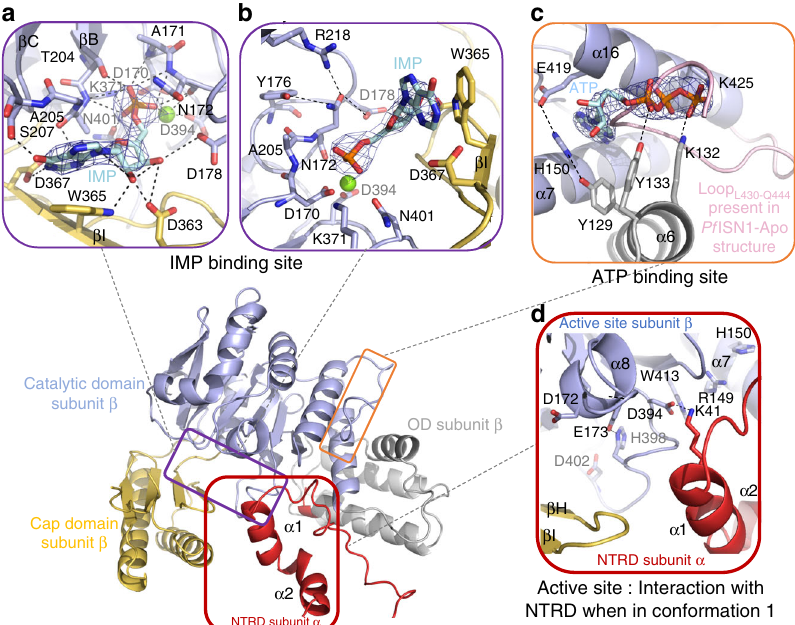
Fig. 4 Structural features of Pf ISN1. a , b Structural organization of the IMP binding site in the substrate binding state . c ATP-binding site in a pre-activated state with the C-terminal loop from the apo structure superposed. d Inter-domain communication of NTRD when this latter is in conformation 1.The 2 Fo – Fc electron-density maps (blue mesh) are contoured at 1 σ and Mg 2 + is depicted as a green Pf ISN1 H150V - Δ C10 is no longer inhibited by ATP and Pf ISN1 H150V -Apo is not activated by ATP (Fig. 3). These observations con fi rm the role of H150 in ATP binding. Indeed